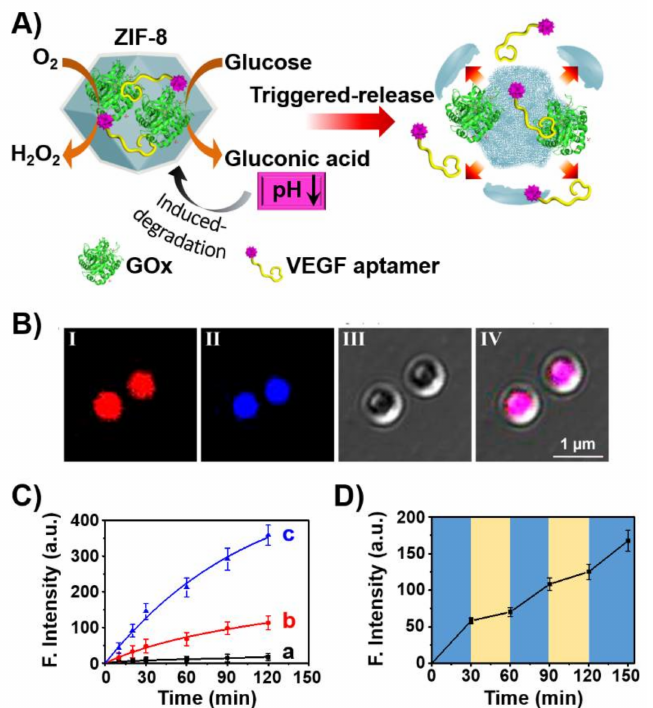
Figure 5. ( A ) Schematic glucose-stimulated release of VEGF aptamer from glucose oxidase (GOx)- loaded ZIF-8 metal-organic framework nanoparticles (NMOFs). ( B ) Confocal microscopy images of the Cy3-labeled VEGF aptamer (I) and coumarin-labeled GOx (II) and bright field (III) and merged images (IV) of the loaded NMOFs. ( C ) Time-dependent release of the Cy3-labeled VEGF aptamer from the GOx/Cy3-labeld VEGF aptamer-loaded ZIF-8 NMOFs at different concentration of glucose: a = 0 mM, b = 10 mM, c = 50 mM. ( D ) Switchable release of Cy3-labeled VEGF aptamer from the GOx/VEGF aptamer-loaded ZIF-8 NMOFs in the presence of high concentration of glucose (15 mM) and low concentration of glucose (5 mM). Reproduced with permission from ref. [103]. Copyright 2018 American Chemical Society. Arrows: it indicates a decrease in the